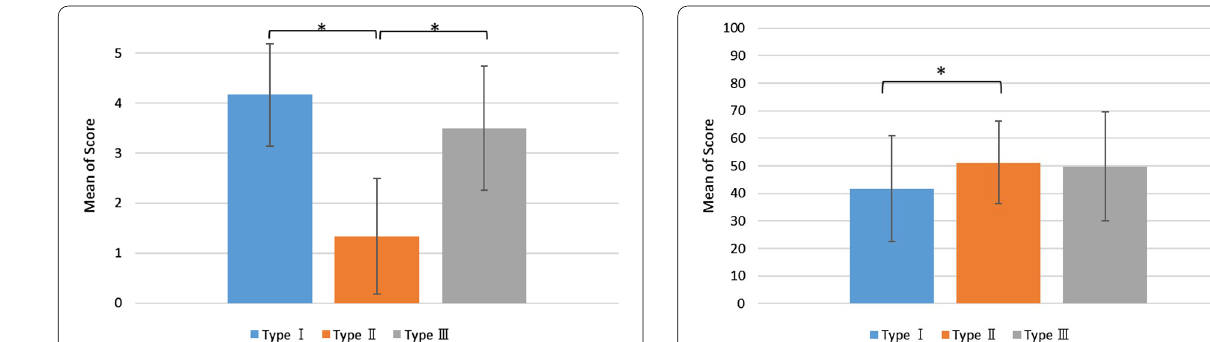
Fig. 12 Means of the score for each type during the reconnaissance activity (*p < 0.05)